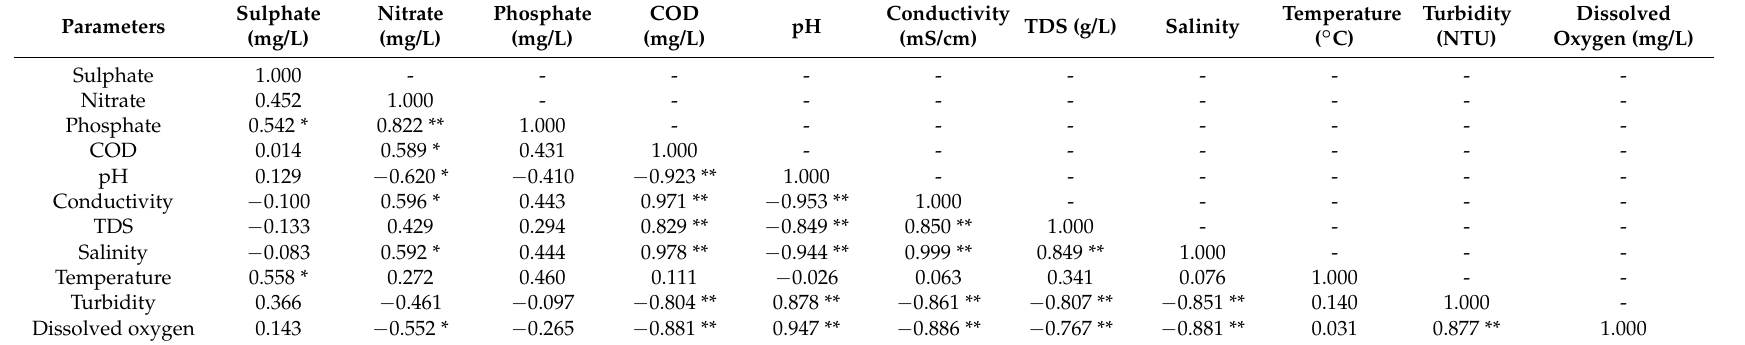
Table 2. Spearman’s rho of in-situ, chemical oxygen demand (COD), and anion concentration of cassava mill effluents treated with Saccharomyces cerevisiae . Sulphate Parameters Sulphate Nitrate Phosphate Conductivity Temperature Turbidity Dissolved